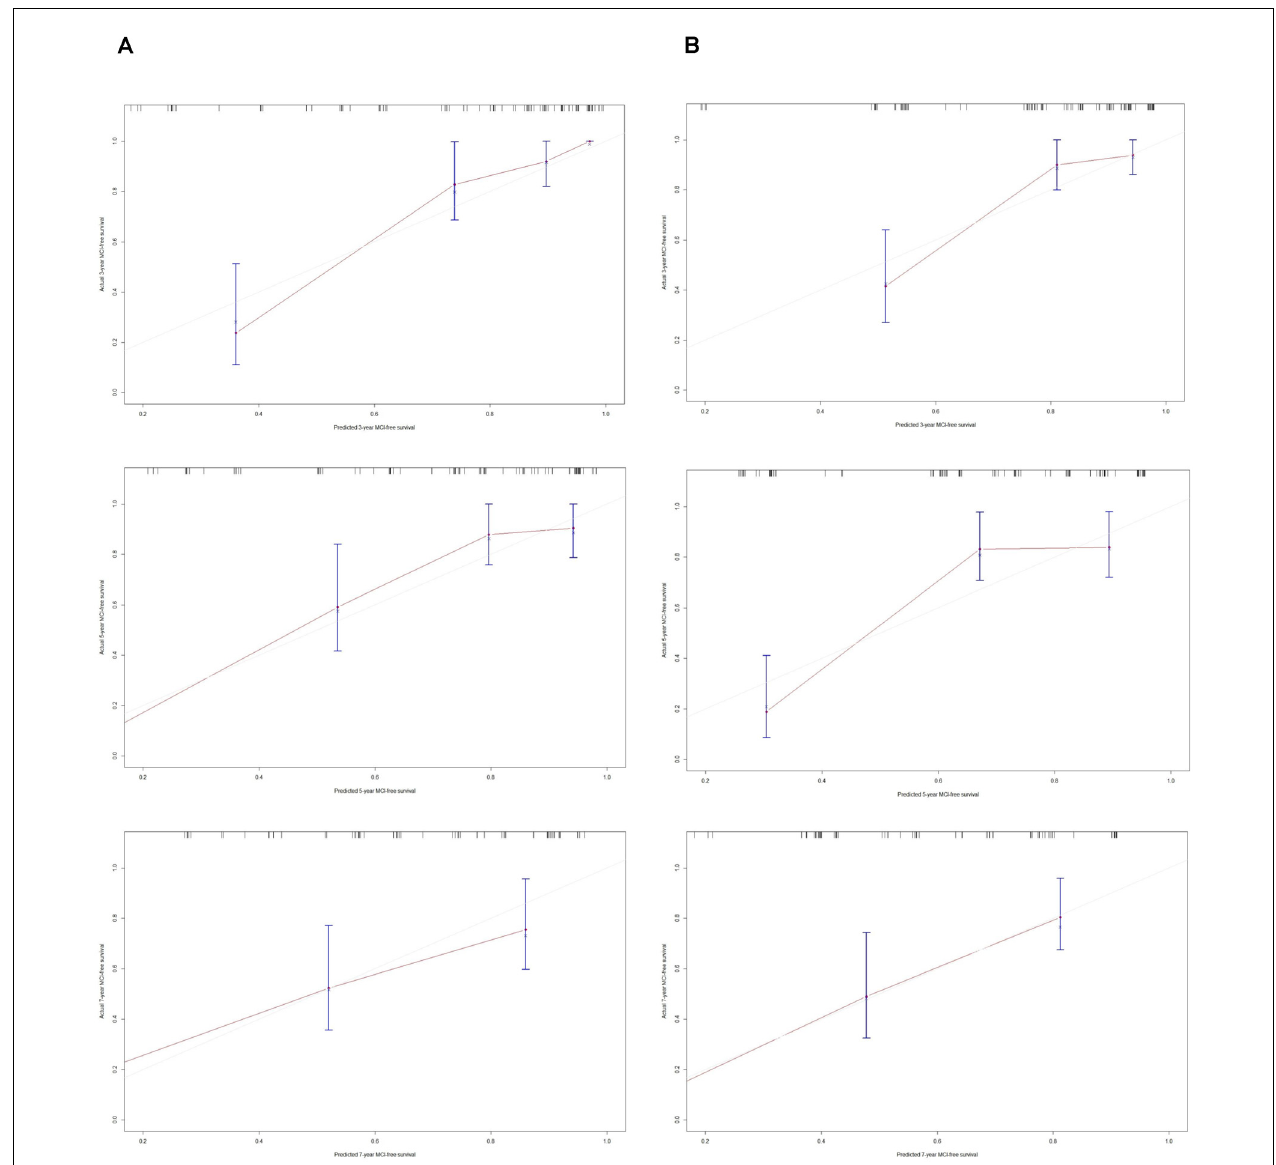
FIGURE 3 | Calibration plots of model-predicted MCI-free survival probabilities at 3 years, 5 years, and 7 years in PD-RBD patients. Model-predicted probabilities of overall survival are plotted on the x-axis; actual overall survival is plotted on the y-axis. (A) The calibration curve of model 1-predicted MCI-free survival probabilities at 3 years, 5 years, and 7 years in the training set, n = 96. (B) The calibration curve of the model 2-predicted probability of MCI-free survival probabilities at 3 years, 5 years, and 7 years in the training set, n =